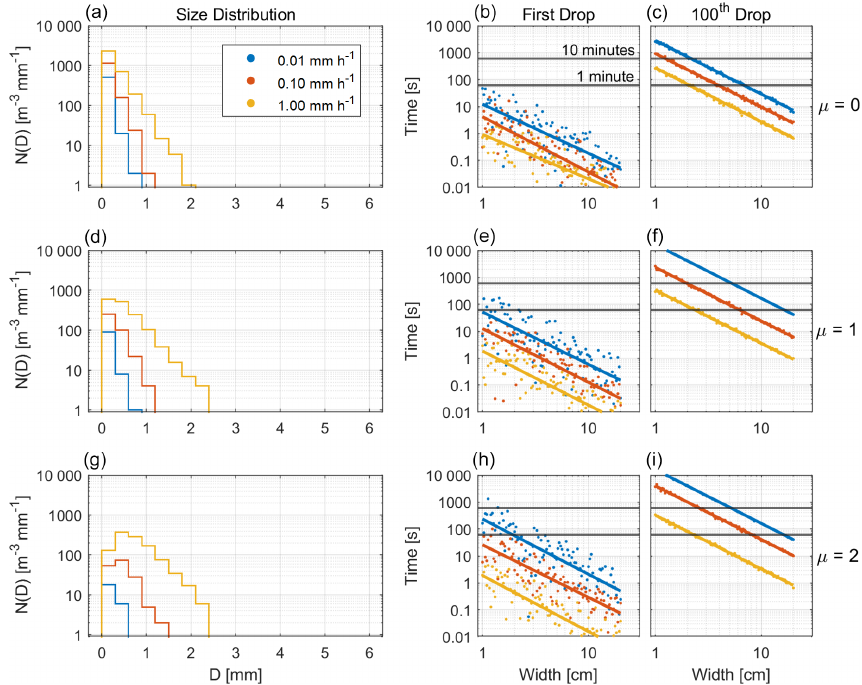
Figure 4. Generated size distributions (a, d, g) , first drop simulation (b, e, h) , and 100th drop simulation (c, f, i) for µ = 0, 1, and 2 (top, middle, and